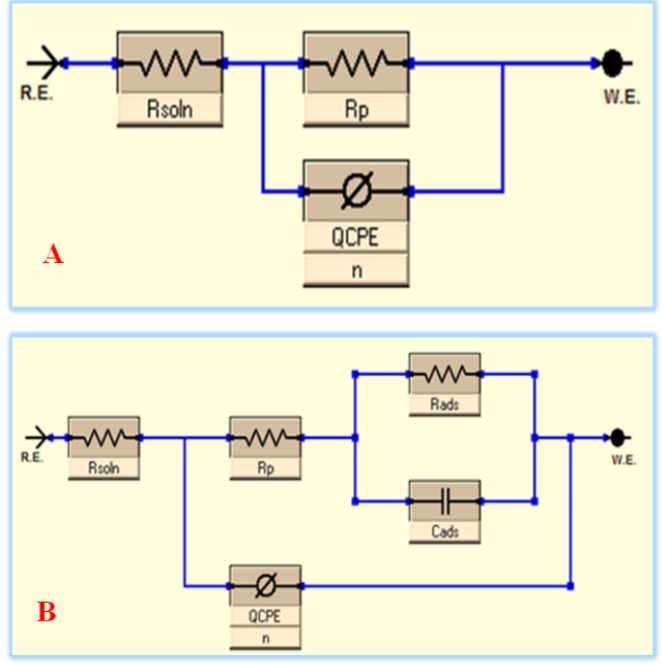
Figure 8. The EEC of unprotected ( A ) and protected systems ( B ).